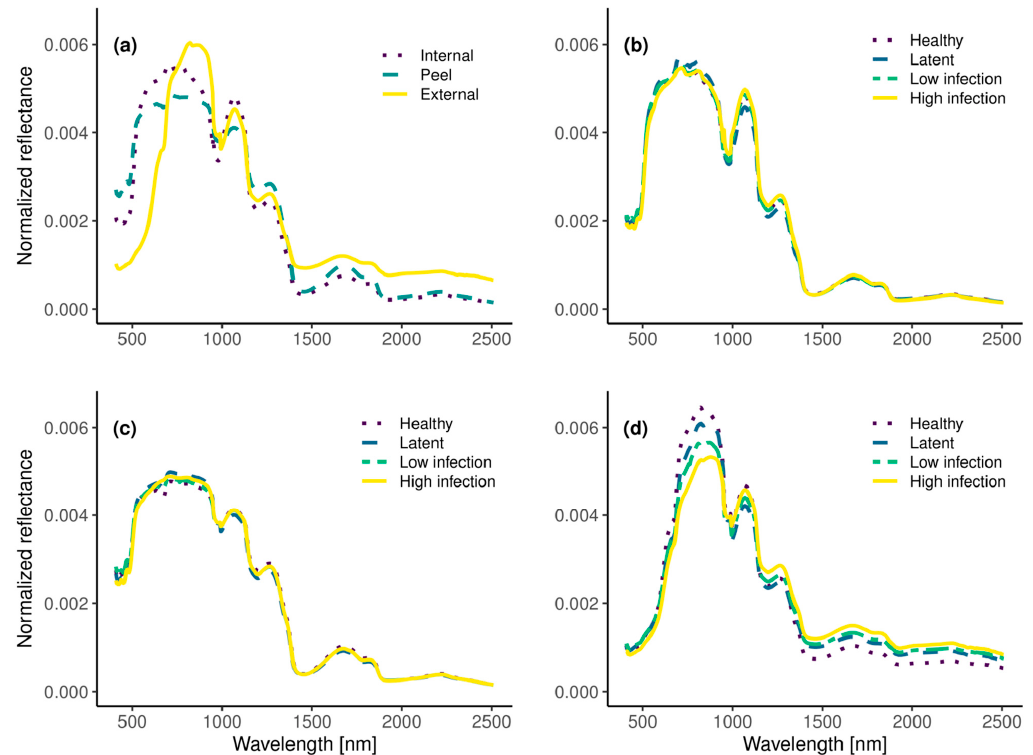
Figure 4. Mean spectral signatures of all groups. ( a ) Tuber preparation groups; ( b ) internal data from halved tubers; ( c ) data from peels; ( d ) epidermis data.